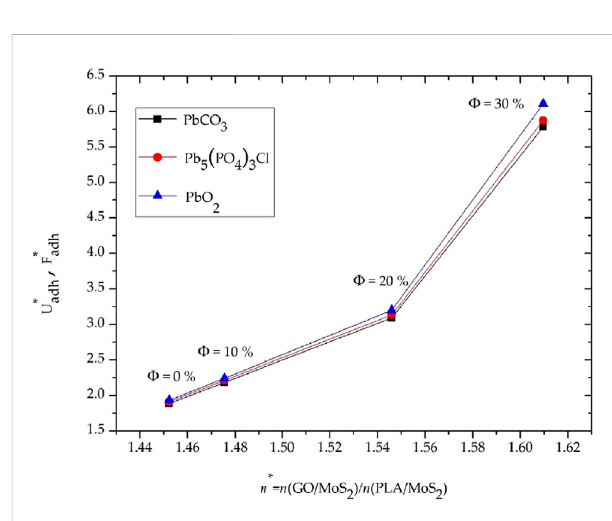
FIGURE 6 Scaled vdW energy and force using Eq. 8 with the same lead adsorbate radius Rp = cte.